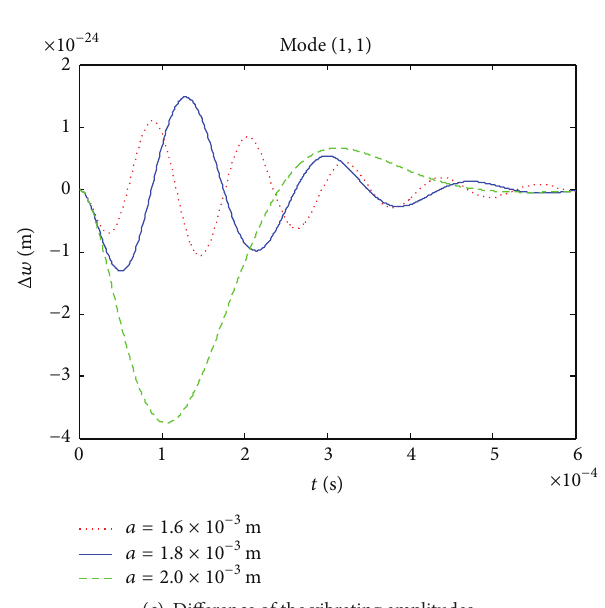
Figure 2: Effects of the van der Waals force on vibrating amplitude of the film center for various 𝑎 .